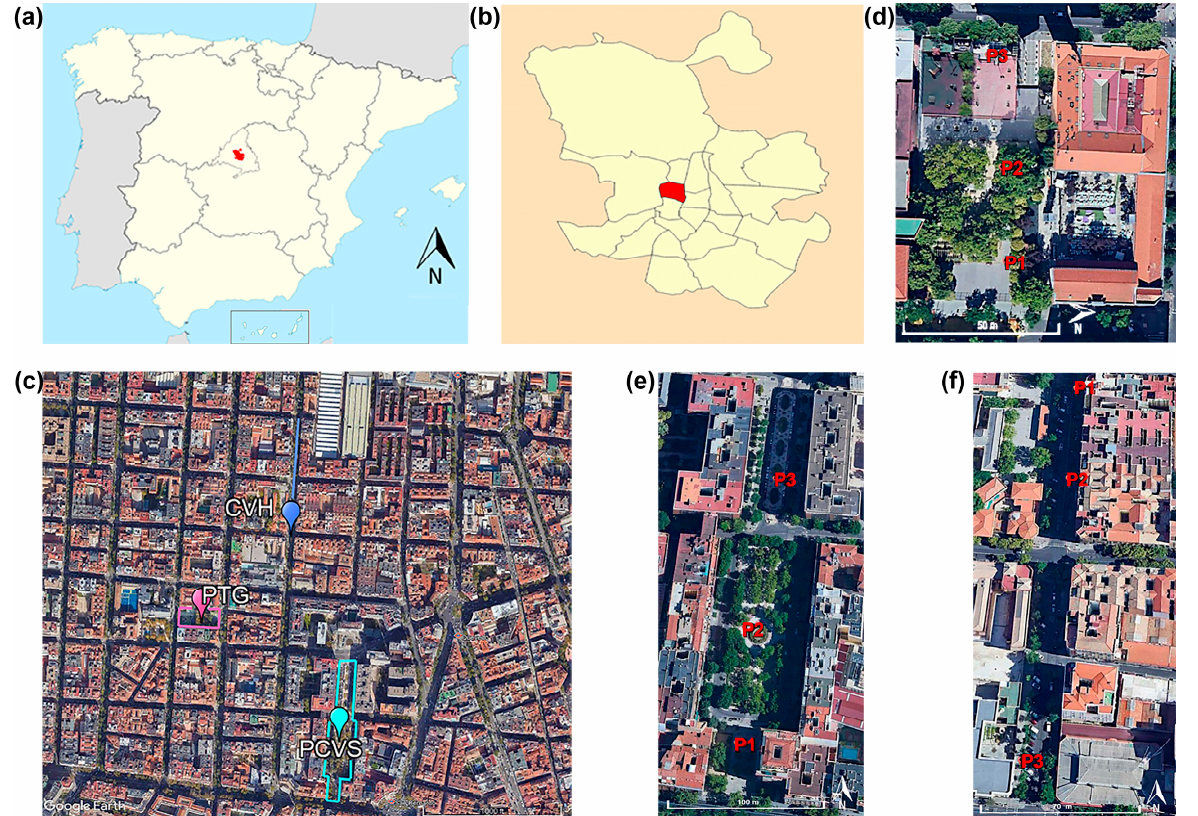
Figure 2. Case study of Madrid. ( a ) Location of Madrid in Spain; ( b ) location of Chamberi district in Madrid; ( c ) location of Park Galileo Theatre (PTG), Conde del Valle de Schill Square (PCVS) and Val ‐ lehermoso street (CVH); ( d ) aerial view of PTG and location of measurement points; ( e ) aerial view of PCVS and location of measurement points, ( f ) aerial view of CVH and location of measurement points.